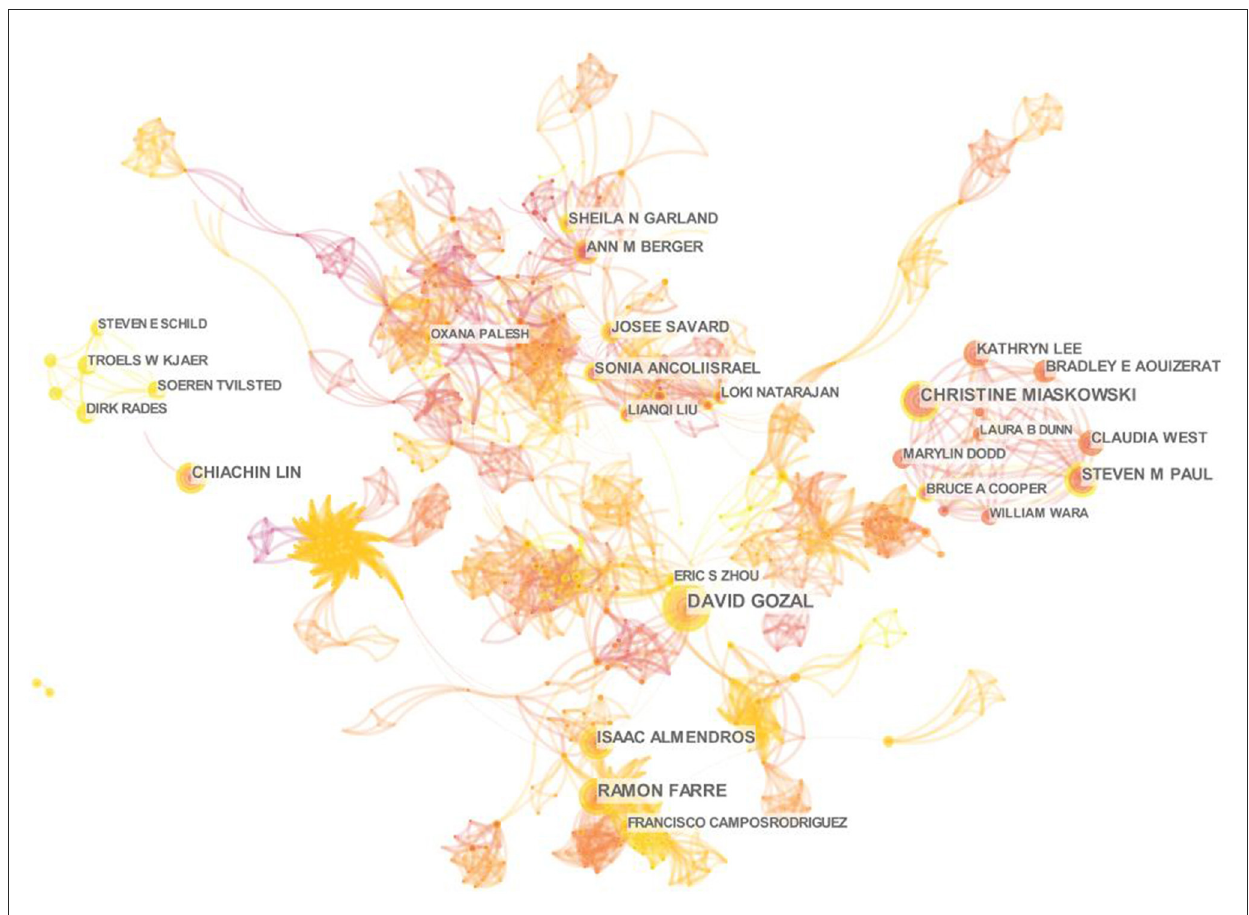
FIGURE4 Collaboration network of authors on cancer and sleep research from 2002 to 2022.